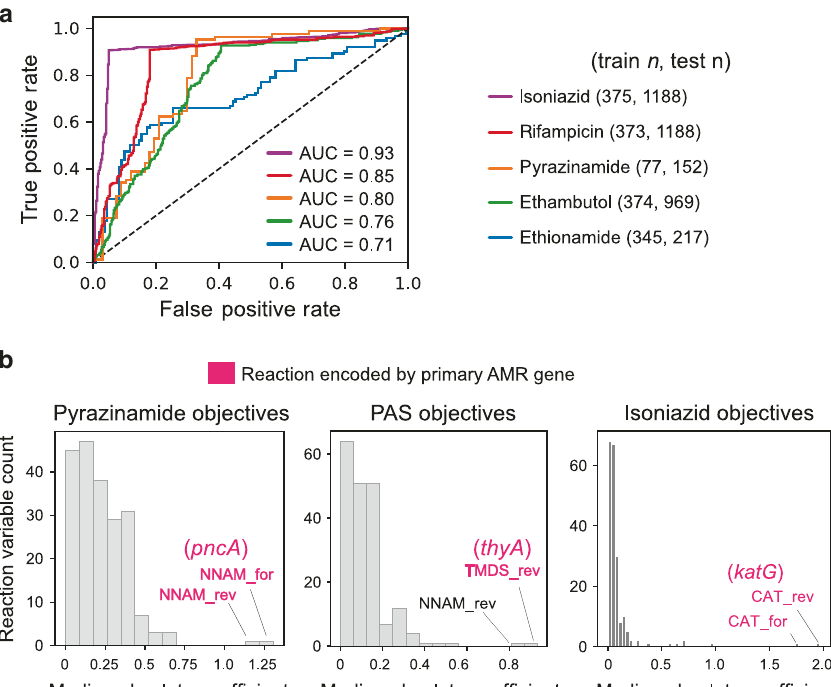
Fig. 2 Validation of metabolic allele classi fi ers. a Receiver operator characteristic (ROC) curves for MAC AMR predictions determined using a test set of 1188 isoniazid-tested strains. b Histogram of median absolute MAC objective function coef fi cients (c y T ) for pyrazinamide, para-aminosalicylic acid, and isoniazid MACs. The reaction variables corresponding to the two largest coef fi cients are noted in text. The reaction variable corresponding to the primary genetic determinant is colored pink. Abbreviations: AUC, area under the